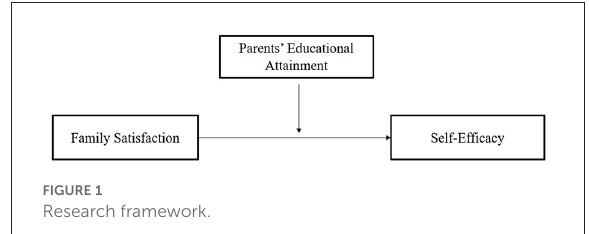
FIGURE1 Research